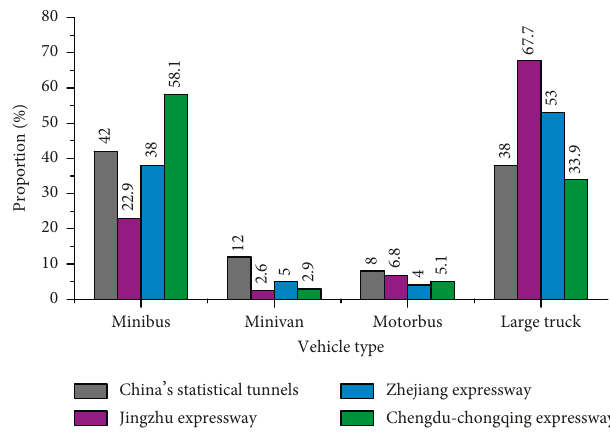
Figure 5: Vehicle types in TTAs.